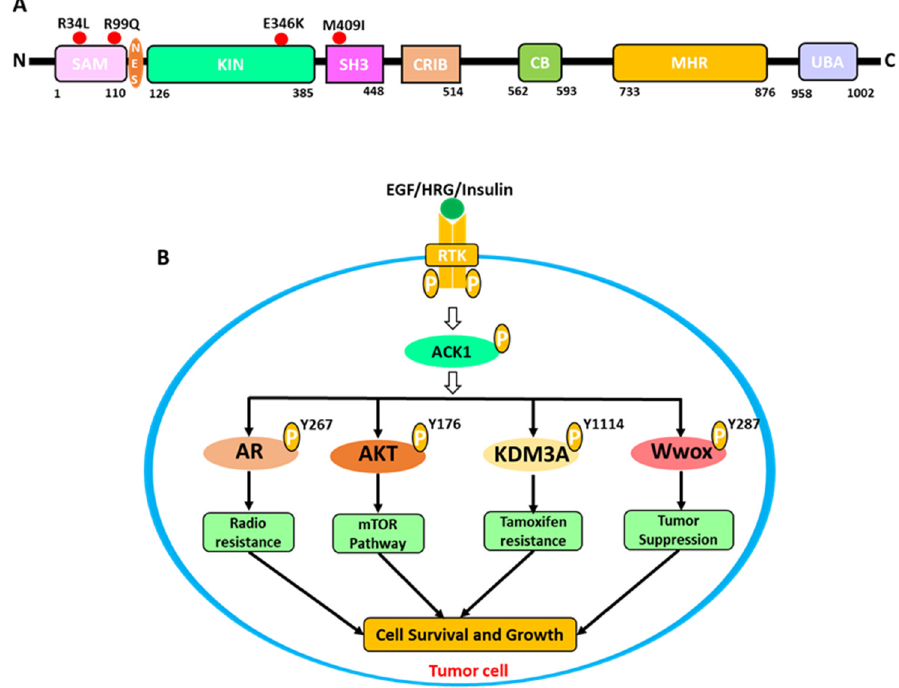
Figure 1. ( A ) Schematic representation of the ACK1 protein domains. The mutations were highlighted with a red circle; among them, the E346K mutation was significantly increased in ovarian cancer. ( B ) The signaling network of ACK1. The activated receptor tyrosine kinase pathway induces cell survival and proliferation by activating ACK1 and its downstream signaling patterners.